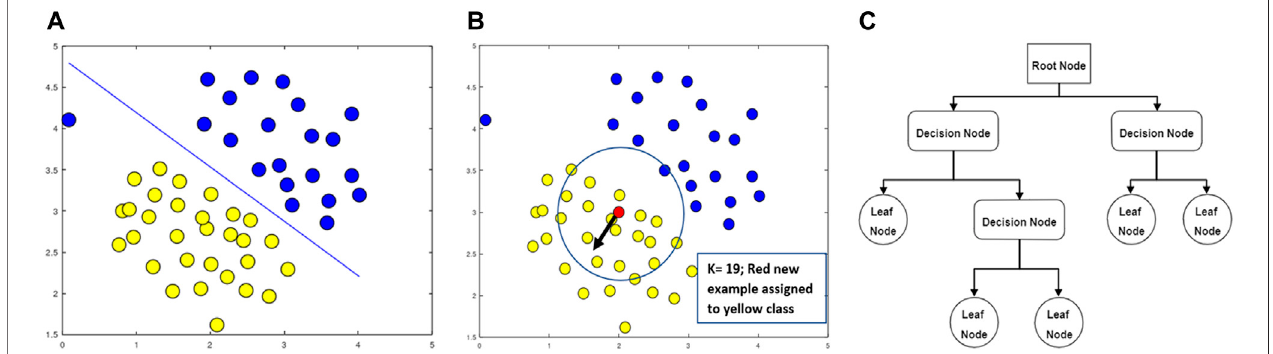
FIGURE 2 | Illustration of different ML algorithms. (A) SVM, (B) K-nearest neighbors and (C) Decision Tree.